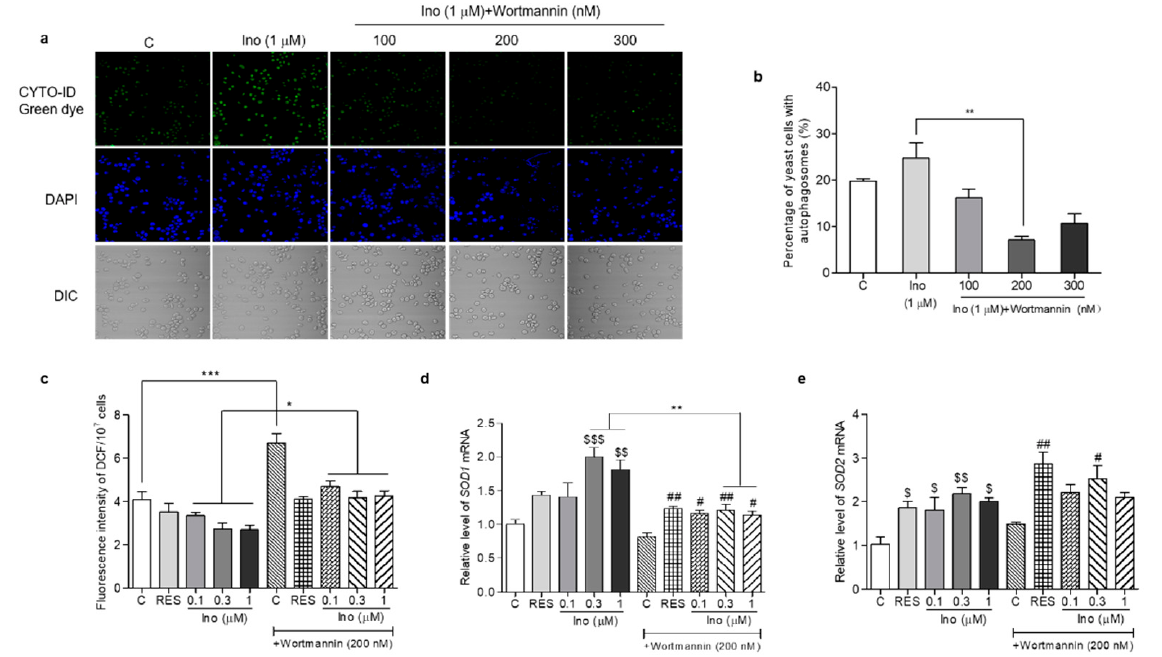
Figure 9. Effects of inokosterone on the ROS, SOD1 and SOD2 gene expression in K6001 yeast after autophagy was blocked by wortmannin. ( a ) Effects of wortmannin on the autophagy of K6001 yeast. ( b ) The digital results of the autophagy in yeast ( a ). ( c ) Changes in the ROS levels in K6001 yeast and K6001 yeast with autophagy blocked by wortmannin at 200 nM after RES and inokosterone treatment. ( d , e ) The SOD1 and SOD2 gene expression in K6001 yeast and K6001 yeast with autophagy blocked by wortmannin at 200 nM after RES and inokosterone treatment. *, **, and *** represent significant differences between the K6001 yeast group and K6001 yeast lacking autophagy. $, $$ and $$$ indicate significant differences between the control group and the treated group in K6001 yeast. # and ## indicate significant differences between the control group and the treated group in K6001 yeast lacking autophagy.